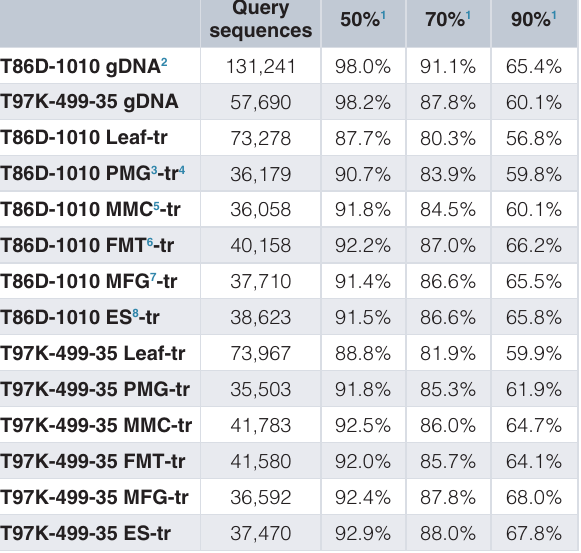
Table 3. Proportion of assembled DNA and tissue-specific transcript contigs that align to the Vigna unguiculata v1.0 reference genome at three thresholds of overlap.